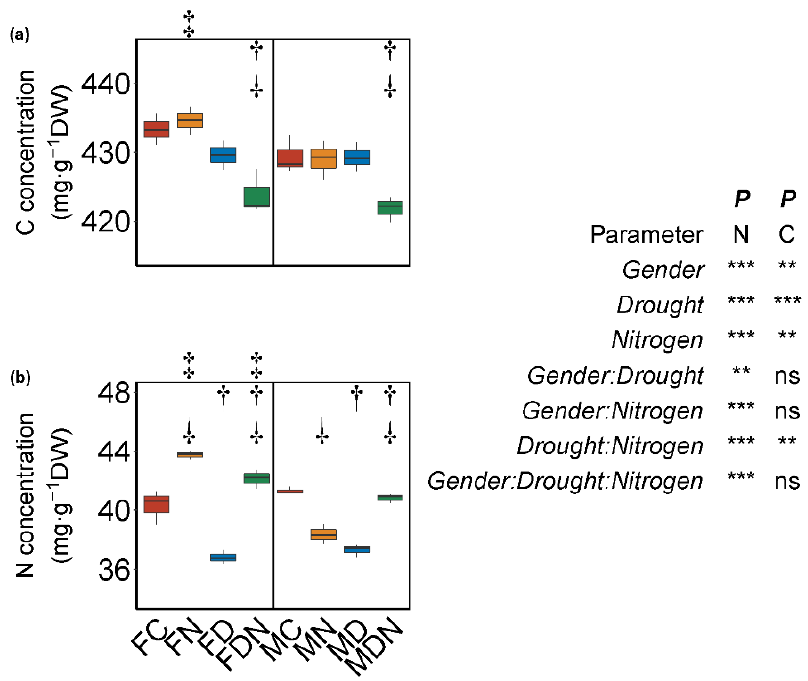
Figure 1. The phenotypic parameters of S. myrtillacea cuttings. ( a ) Morphology of cuttings after Figure 3. The foliar C and N concentration of S. myrtillacea cuttings ( n = 3). ( a ) C concentration; ( b ) treatments. The black line denotes 10 cm length; ( b ) the height of cuttings ( n = 6); ( c ) the base diameter of cuttings ( n = 6). F, females; M, males; C, control; N, N deposition; D, drought; DN, N concentration. F, females; M, males; C, control; N, N deposition; D, drought; DN, drought and N and N deposition. The double dagger (‡) indicates simple effect of gender, the dagger (†) indicates drought and N deposition. The double dagger (‡) indicates simple e ff ect of gender, the dagger (†) indicates simple effect of drought, and the inverted dagger ( ⸸ ) indicates simple effect of N simple effect of drought, and the inverted dagger ( deposition. Different letters indicate significant differences (Tukey test, p < 0.05). The black dot indicates outlier. Asterisks denote significant differences: ***, p < 0.001; **, p <